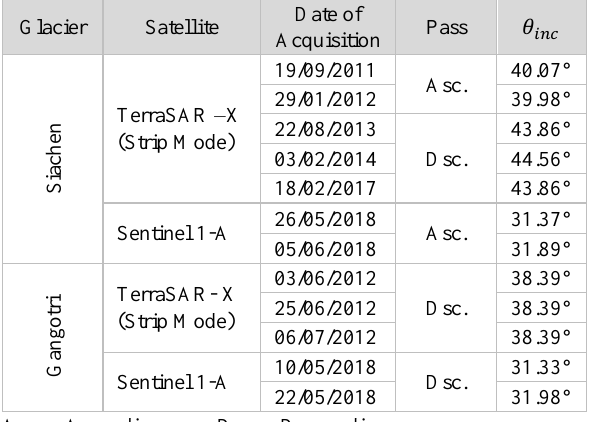
Table 1: List of TerraSAR-X & Sentinel-1A data